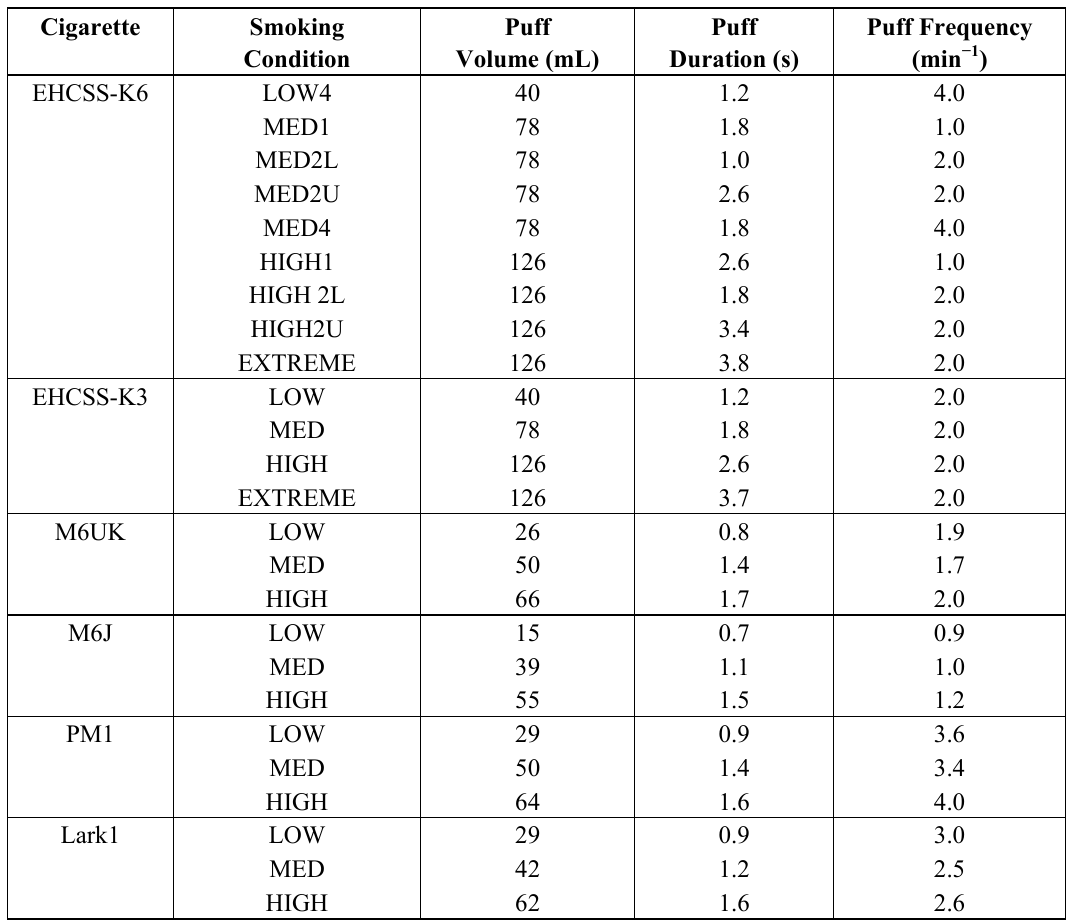
Table 2. Smoking machine puffing regimens for conventional cigarettes (Reprinted from [90], with permission from Elsevier).